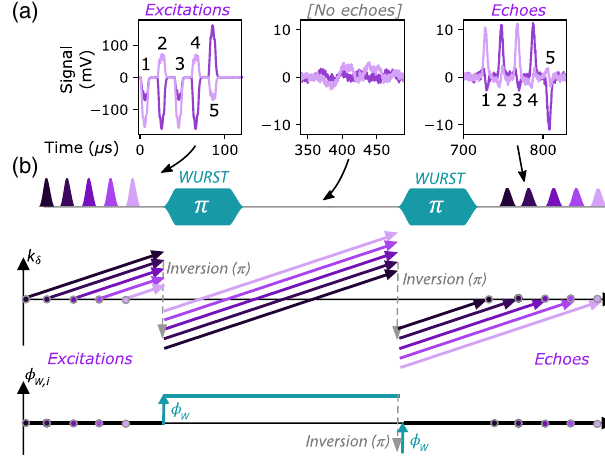
FIG. 7. First-in, first-out (FIFO) time-bin encoding of multiple echoes. (a) An experimental demonstration of multiple excita- tions stored using the FIFO protocol with two identical WURST pulses. The pattern of excitation or echo phases allows echoes and excitations to be unambiguously matched. (b) Schematic showing evolution of spin waves and WURST phase resulting in the FIFO encoding with